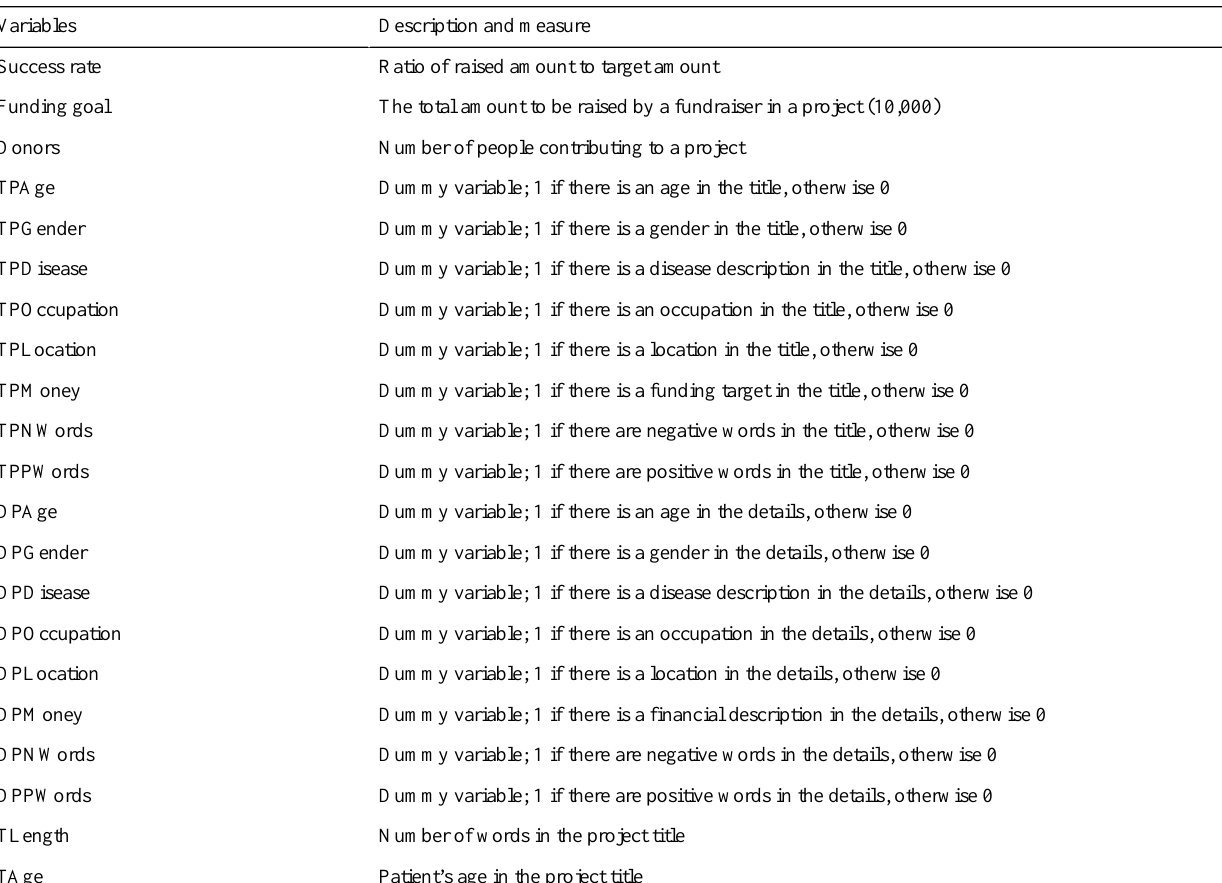
Table 2. Description of the